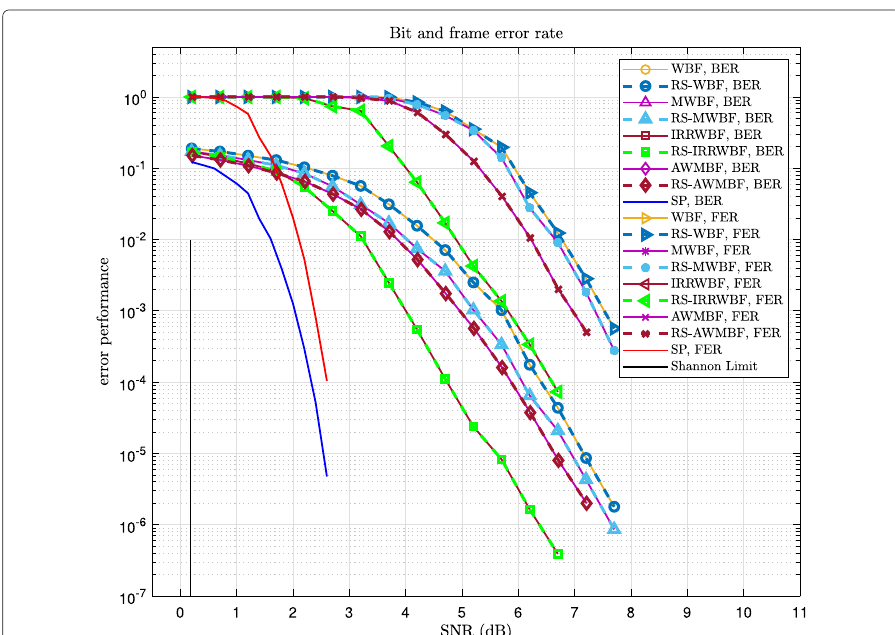
Fig. 7 Performance of (3,6)-regular LDPC code with rate 1